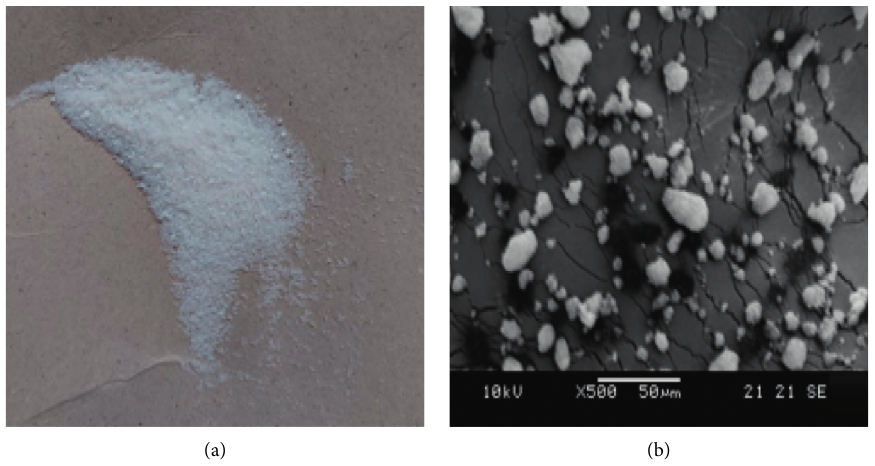
Figure 6: (a) Image of nano-silica. (b) SEM image of